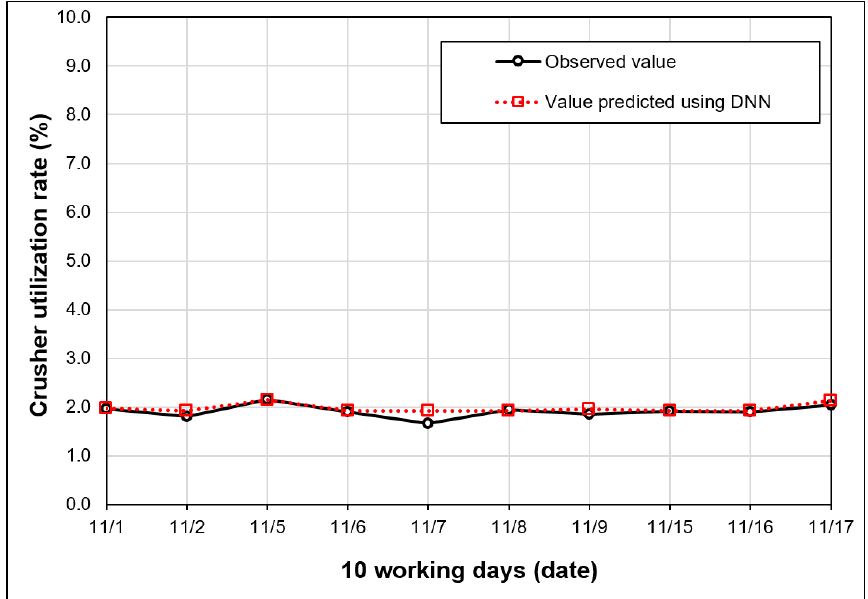
Figure 11. Comparison of measured crusher utilization and value predicted using optimal DNN model.